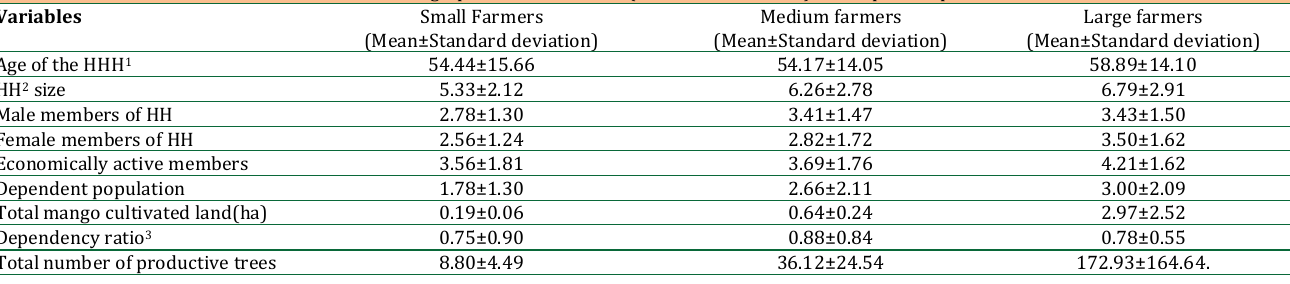
Table 1 : Socio-demographic characteristics (continuous variable) of sampled respondents